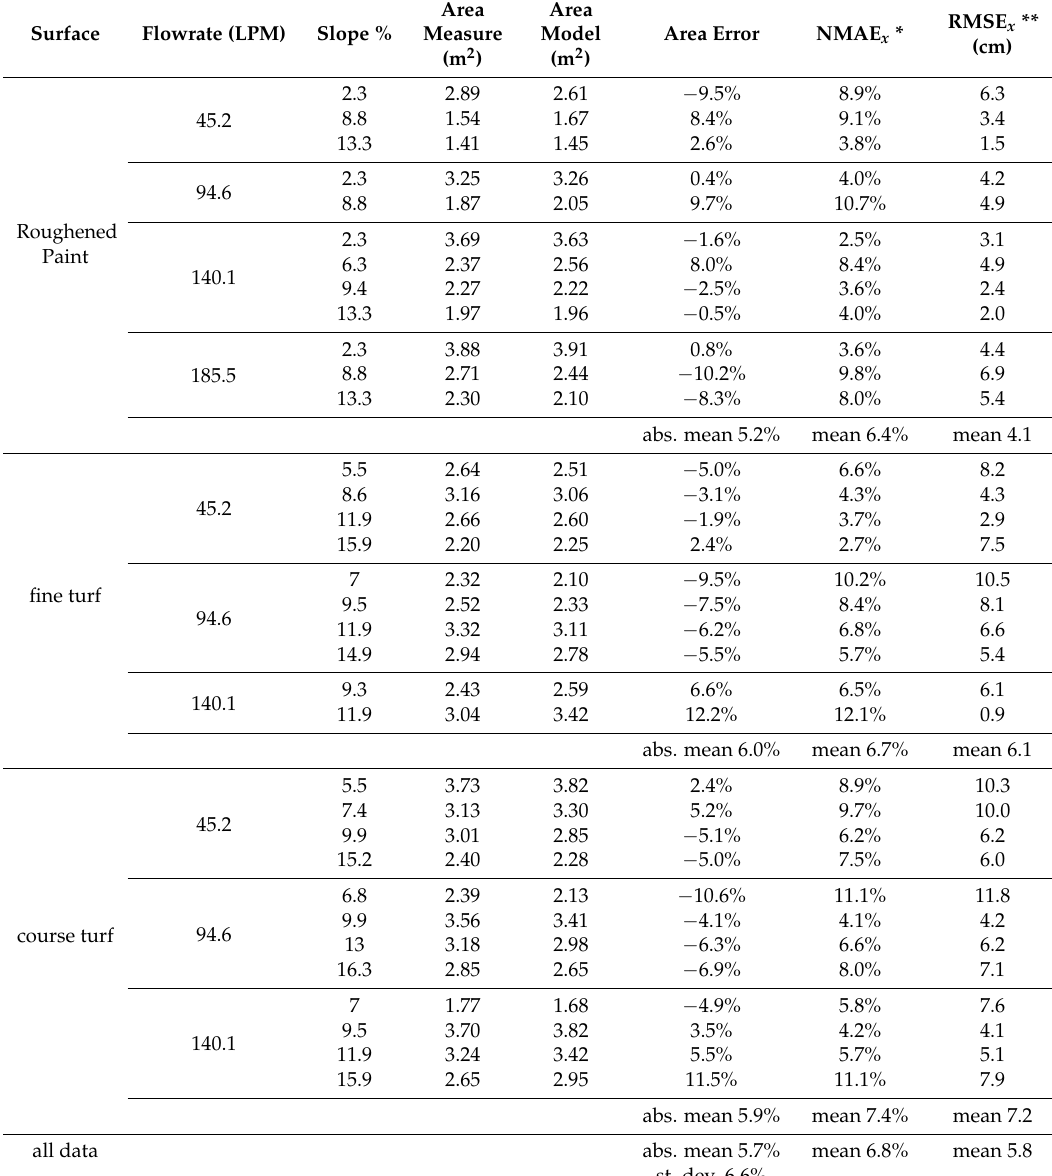
Table 2. Summary statistics of results from measured and modeled